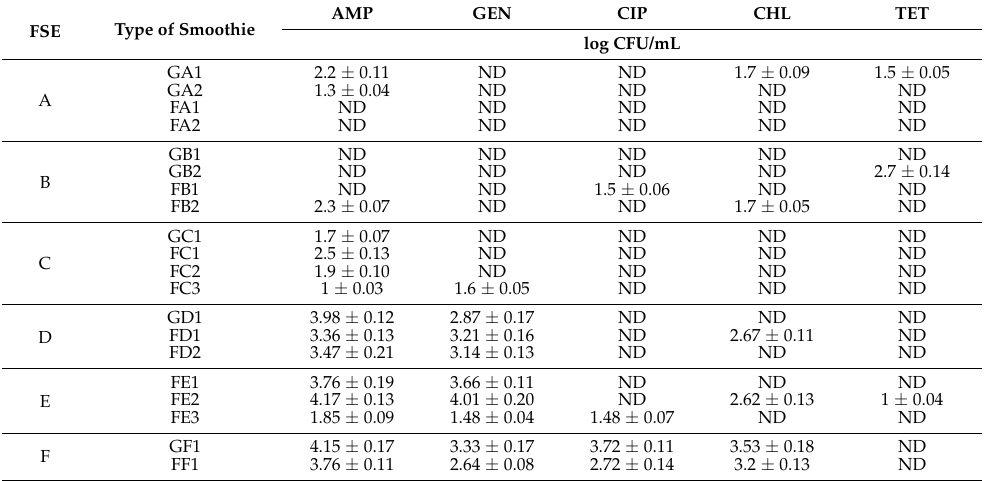
Table 4. Occurrence of antibiotic-resistant coliform bacteria in samples of smoothie.